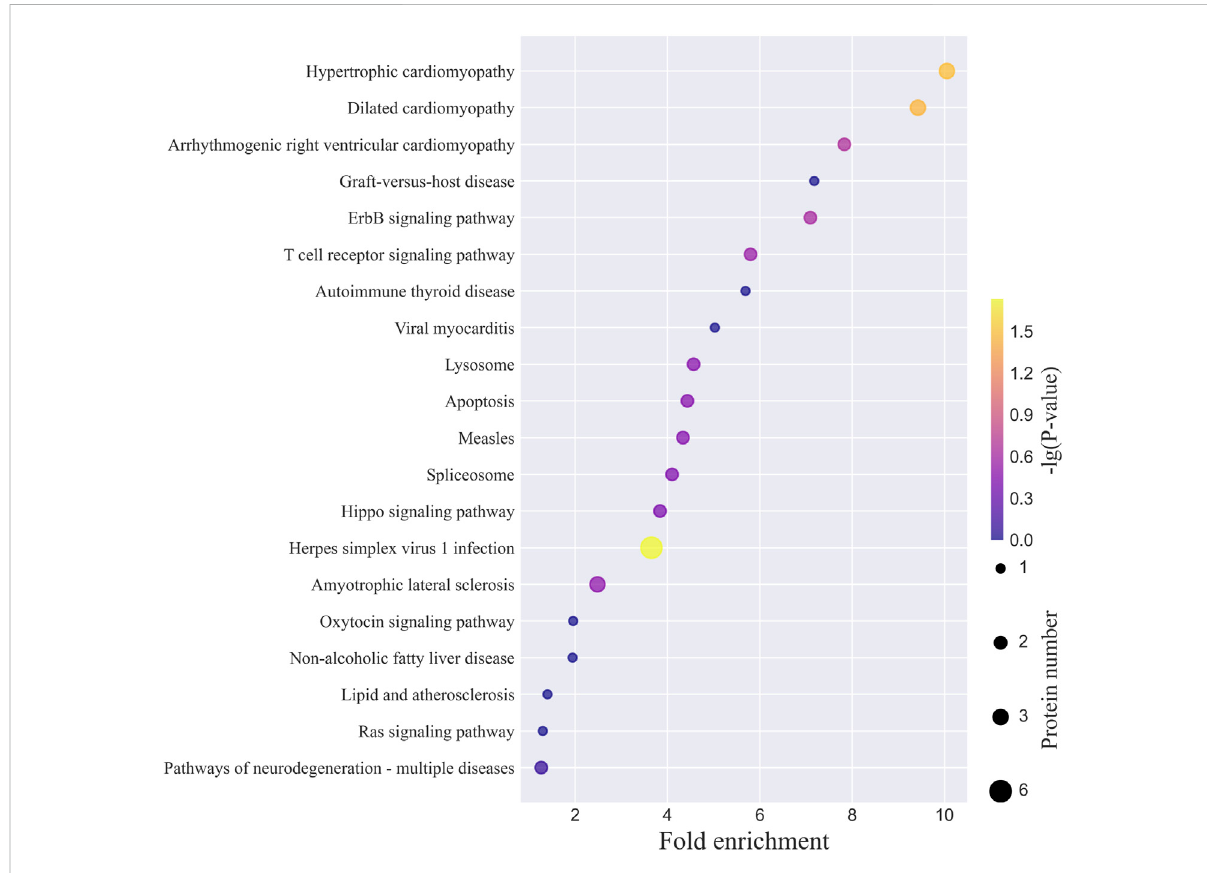
FIGURE 6 Top 20 KEGG pathways of N-glycoproteins corresponding to intact N-glycopeptides with Neu5Gc identi fi ed from MCF-7 cancer